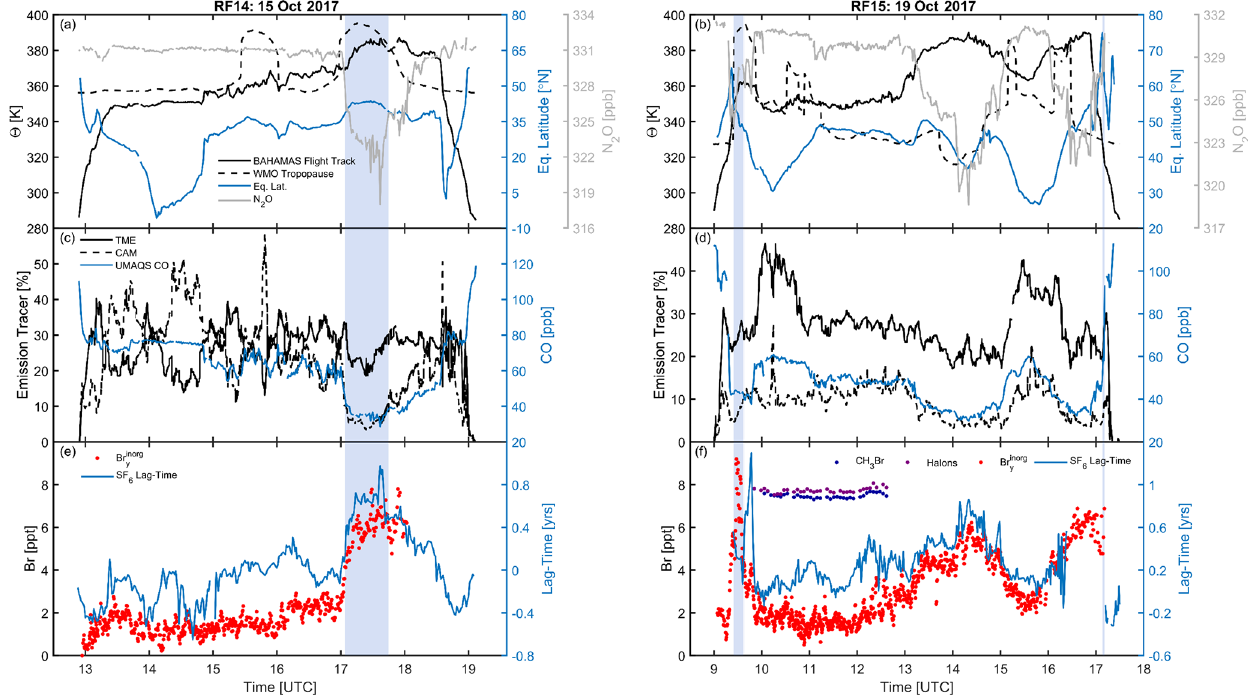
Figure 12. Examples of recent air mass surface emissions from the tropical marine environment (TME) in southeastern Asia as well as elevated emissions from Central America (CAM) during flights in remnants of tropical cyclones. (a, c, e) show details of RF14 on 15 October 2017 and (b, d, f) RF15 on 19 October 2017. (a–b) show the potential temperature of the flight track (solid black line) and WMO TP (dashed black line) for each flight, along with the equivalent latitude (blue line, right axes) and N 2 O VMR (gray, right axes). (c–d) show the air mass fraction at flight altitude from the TME and CAM emission tracers (solid and dashed black lines, respectively), as well as the CO VMR (blue, right axes). (e–f) show the individual bromine mixing ratios of CH 3 Br (dark blue points), the halons (purple points), and Br inorg y (red points) where available along with the air mass lag time (blue line, right axes). The light blue shading indicates Br inorg y > 4ppt in the UT, i.e., (cid:49)(cid:50) <